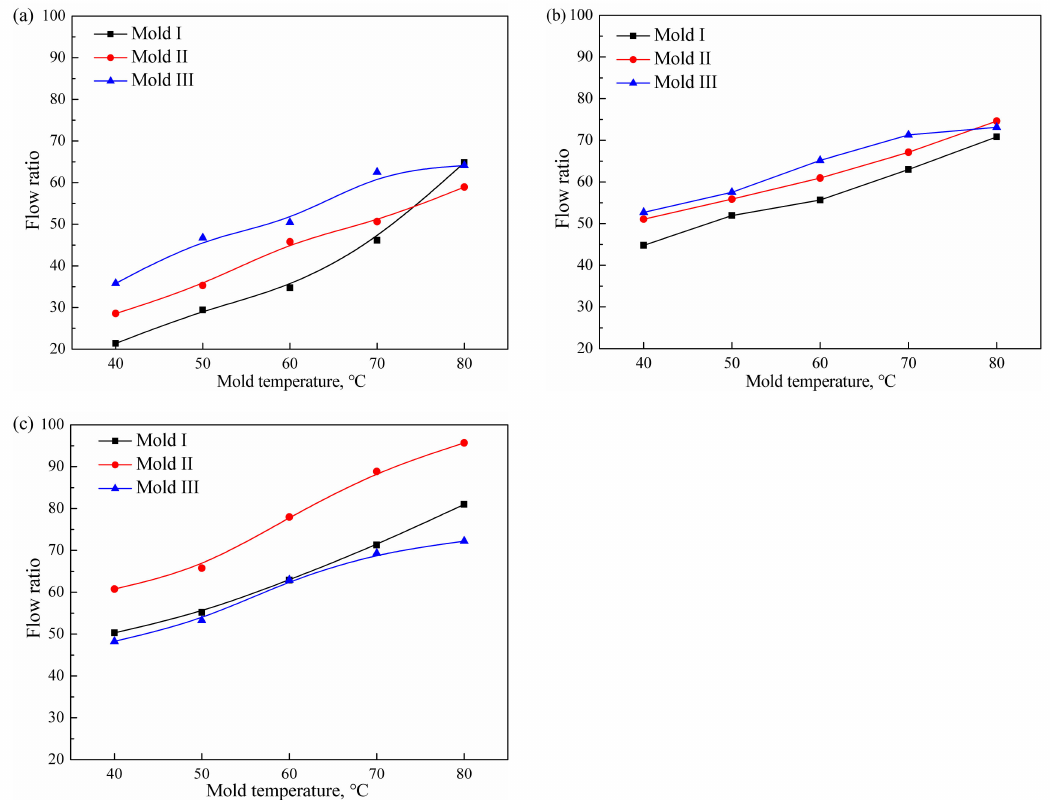
Figure 8. Flow ratios of polymers in different molds ( a ) PMMA; ( b ) PP; ( c )